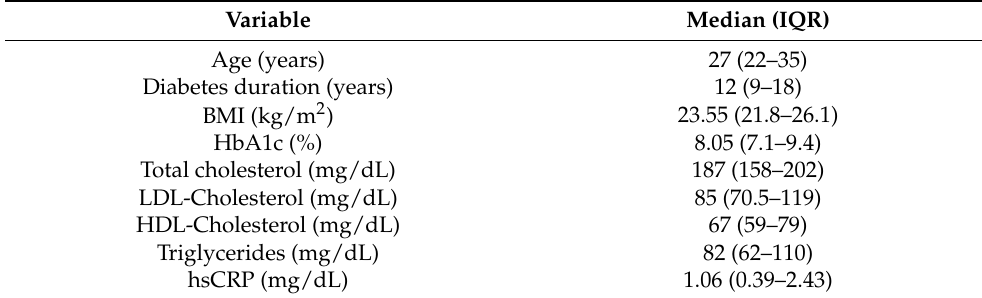
Table 1. The characteristics of examined group n =